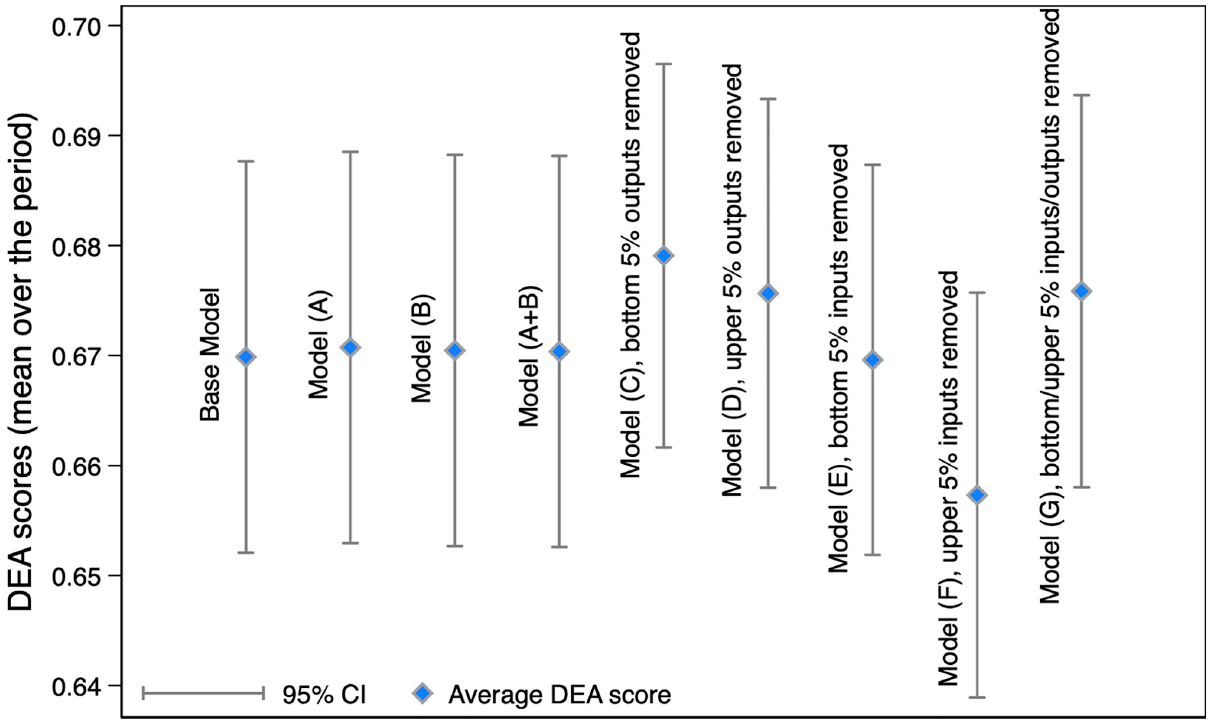
Fig 7. Average bias-corrected efficiency scores by sensitivity analysis model. Notes : 95% CIs were not added as y-axis scale is small. No notable differences are observed in average bias-corrected efficiency scores. T-test between the values were applied and p-value > 0.1 for all comparisons. There were 76, 77, 77, 74, 72 number of countries and 643, 619, 659, 617, and 571 observations included for Model C, D, E, F, and G, respectively. DEA scores stand for technical efficiency